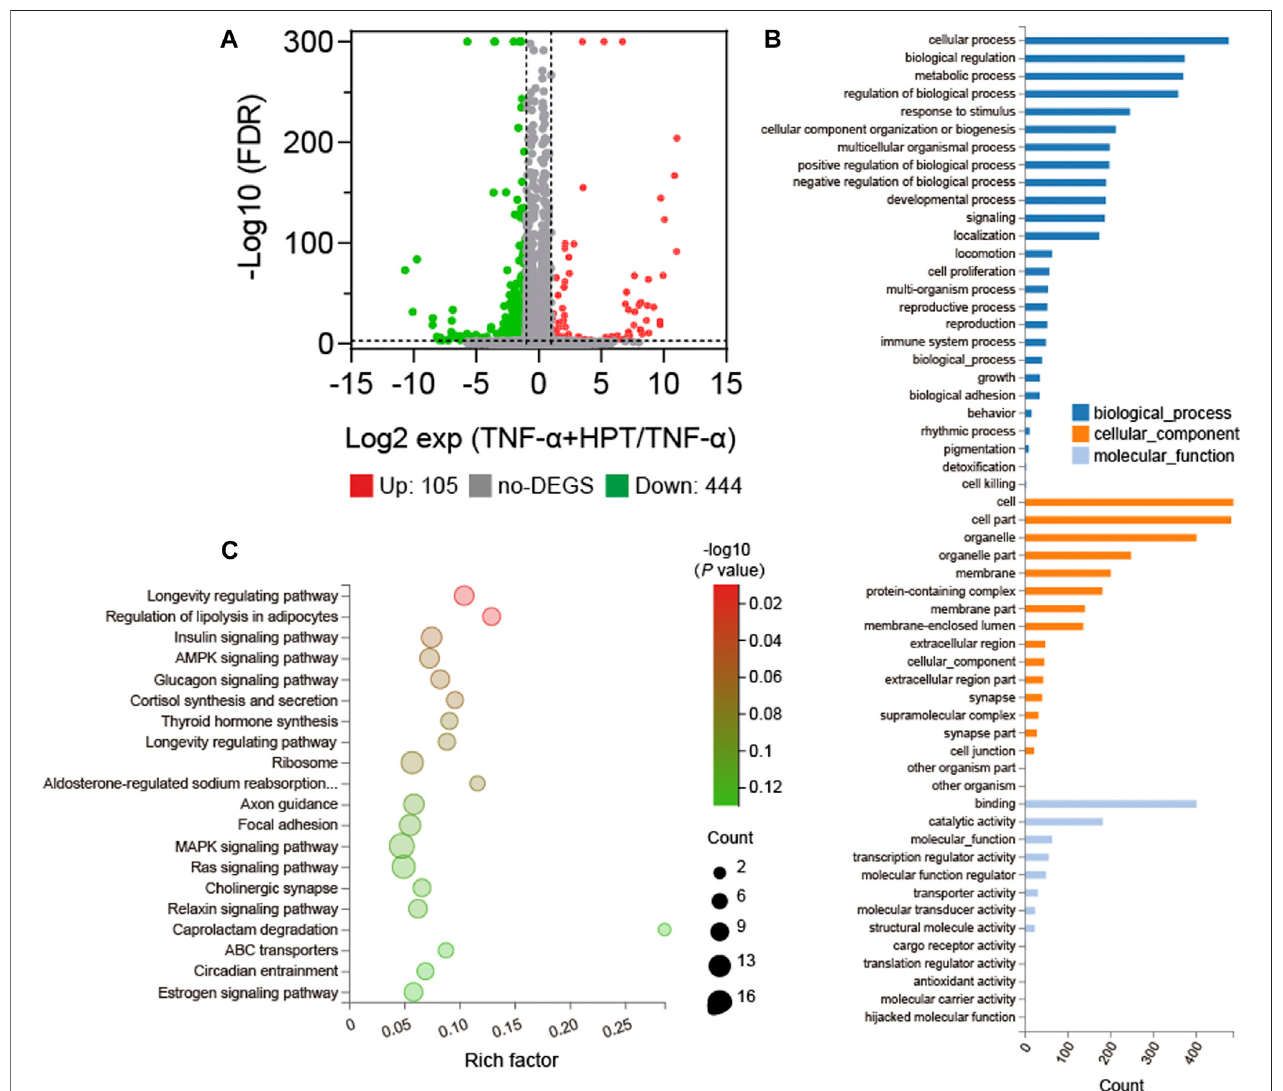
FIGURE 4 | Gene expression pro fi le with or without 10 µM HPT treatment. (A) Volcano map of differentially expressed genes (DEGs) in HPT and control (upregulation: 105; downregulation: 444), FC (fold change) > 1 was considered as a positive DEGs. (B) GO enrichment those common choices for DEGs including biological processes (blue), cellular components (orange), and molecular functions (light blue). (C) Enrichment bubble chart based on the KEGG enrichment analysis. A larger p value indicates a higher degree of enrichment.